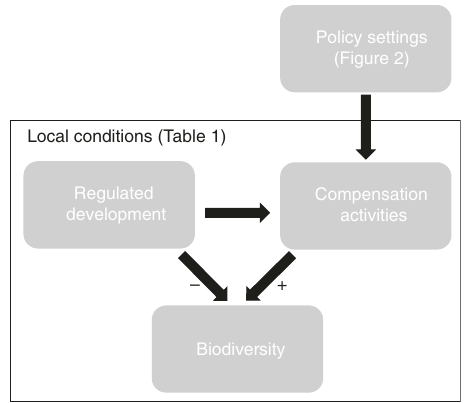
Fig. 5 Conceptual framework used to examine the impacts of regulated development and compensation activities on biodiversity, under various policy settings and local conditions. We manipulated compensation policy settings (see Fig. 2), measured their impact on biodiversity across four case studies that differed in local conditions (Table 1), and compared the biodiversity gains made by compensation activities to the biodiversity losses due to regulated